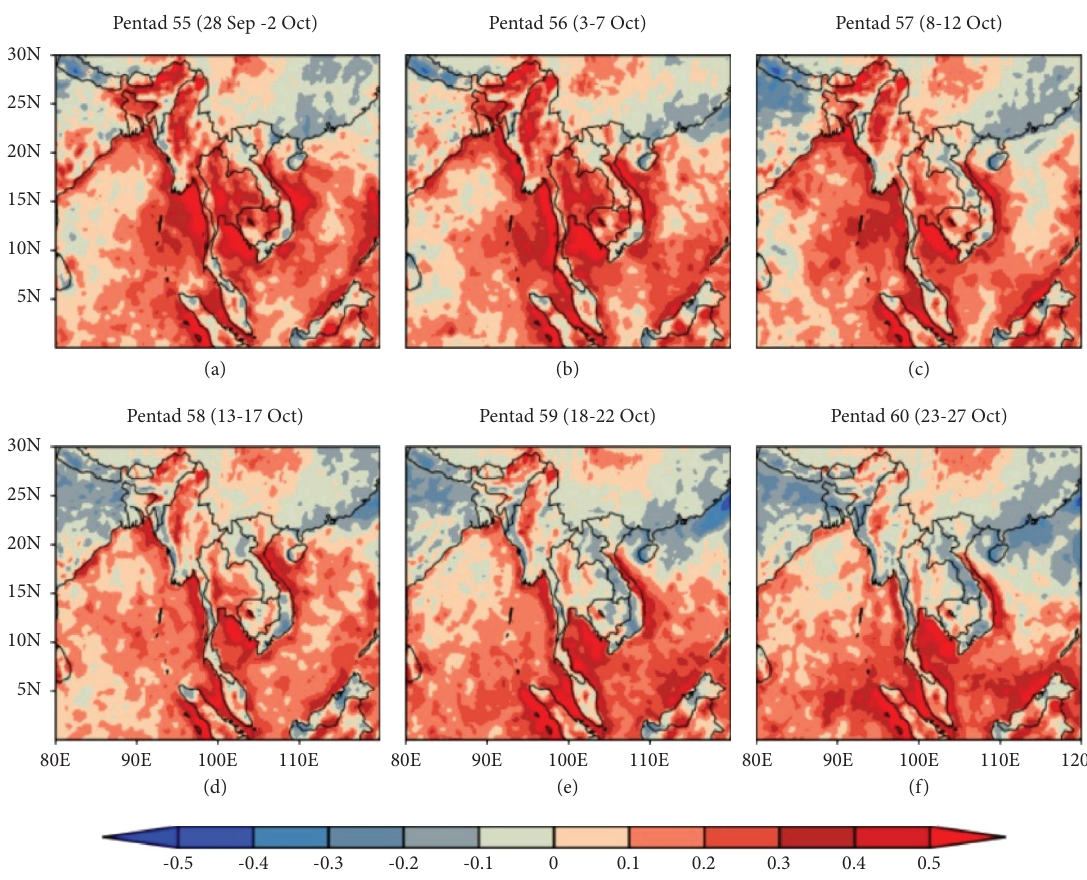
Figure 16: Composite of climatology (1991–2020) moisture convergence (kg m − 2 s − 1 , colour) during the pentads: (a) P -55 (Sep 28–Oct 2), (b) P -56 (Oct 3–7), (c) P -57 (Oct 8–12), (d) P -58 (Oct 13–17), (e) P -59 (Oct 18–22), and (f) P -60 (Oct 23–27) during the monsoon withdrawal period.